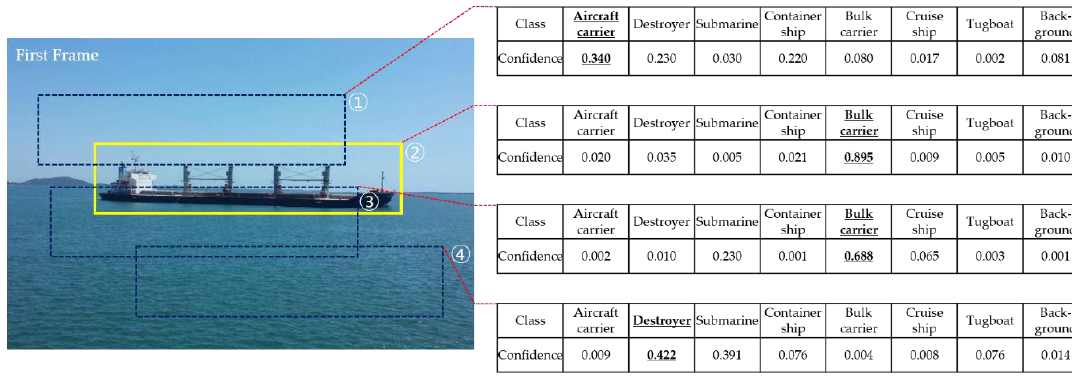
Figure 4. Initial bounding box selection in the first frame.